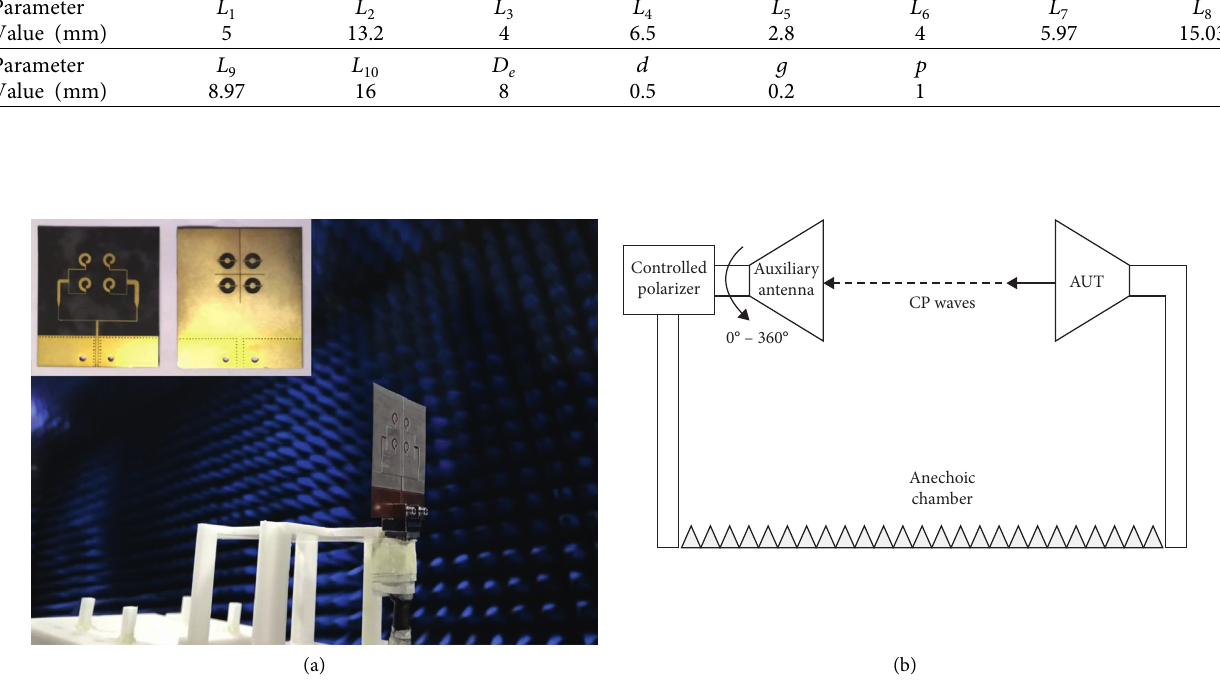
Figure 9: Photos of the top view, the back view, and the measurement system for the fabricated